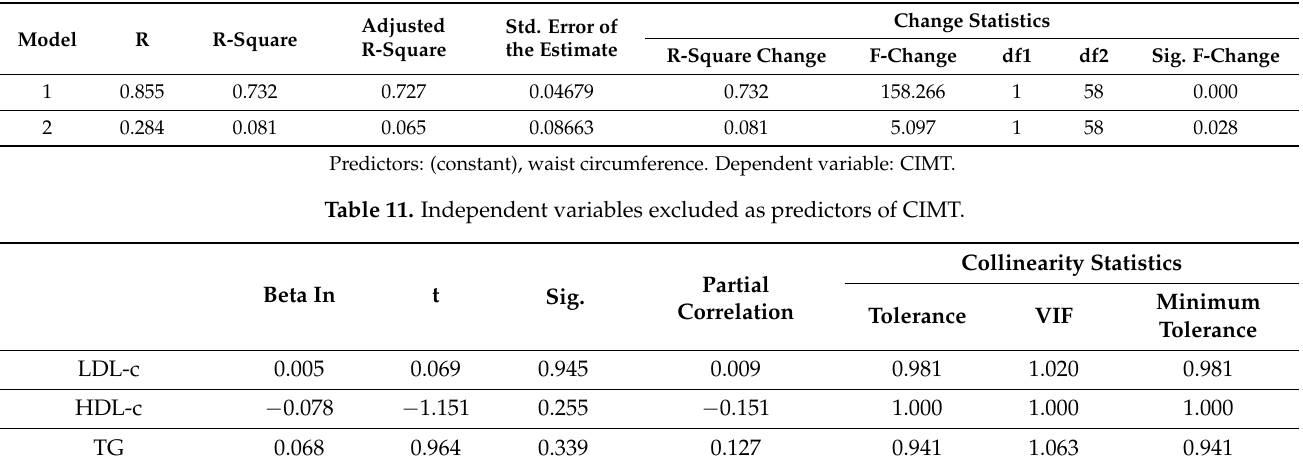
Figure 11. Correlations between CIMT and ( a ) TG:HDL-c ratio in overweight children, ( b ) TG:HDL-c ratio in obese children, and ( c ) TC:HDL-c ratio in obese children. Table 10. WC and TG/HDL-c as significant predictors of CIMT.